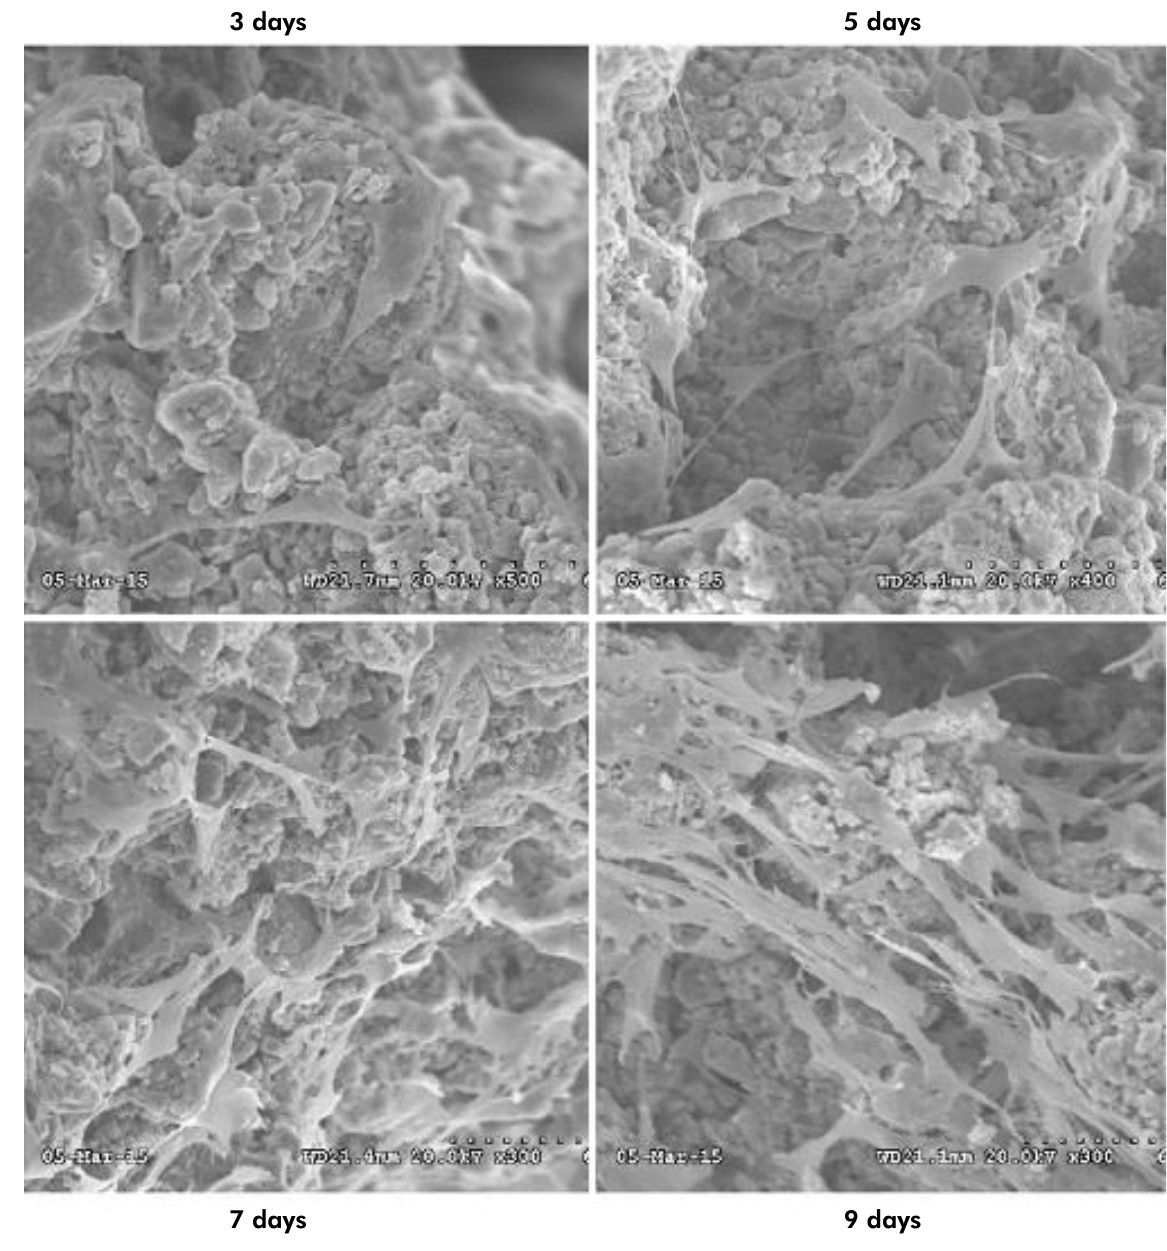
Figure 3. Scanning electron micrographs of DFCs cultured on a 3D OsteoBone TM scaffold. The DFCs were seeded on scaffolds after 3, 5, 7, and 9